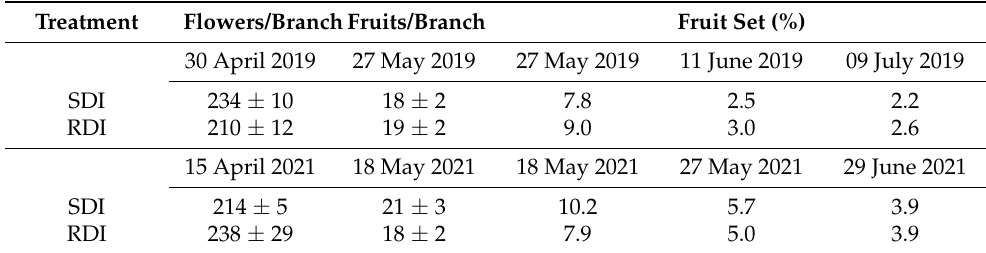
Table 4. Average flower and fruit numbers in 15 cm long branches and fruit set calculated as the percentage of fruit to flower numbers for five replicate plots per